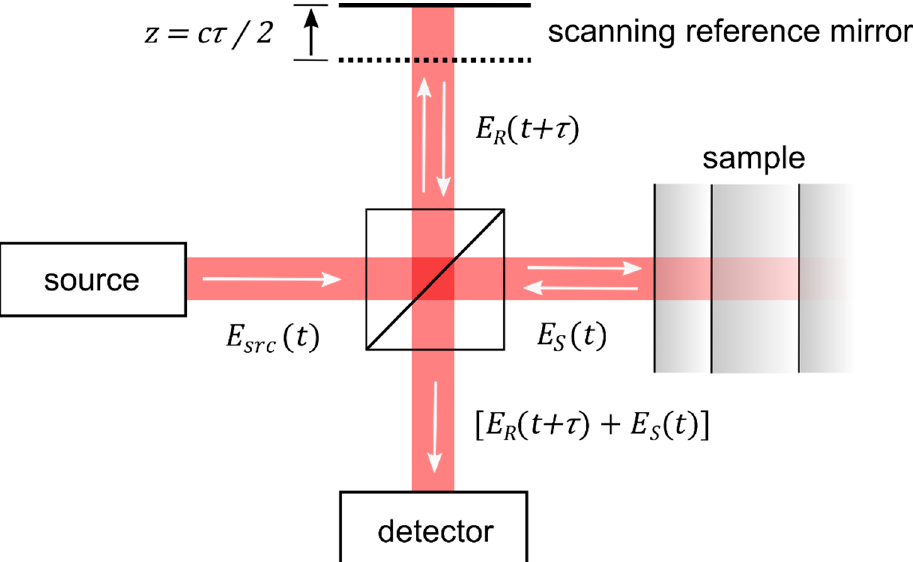
Figure 1. Principle of optical coherence tomography. The technique is comparable to a Michelson interferometer with the sample placed at one interferometer arm. Scanning the length of the reference arm allows one to determine the time-of-flight of the beam which is backscattered from the sample. Variables are as in the text. Image from [8], with permission.